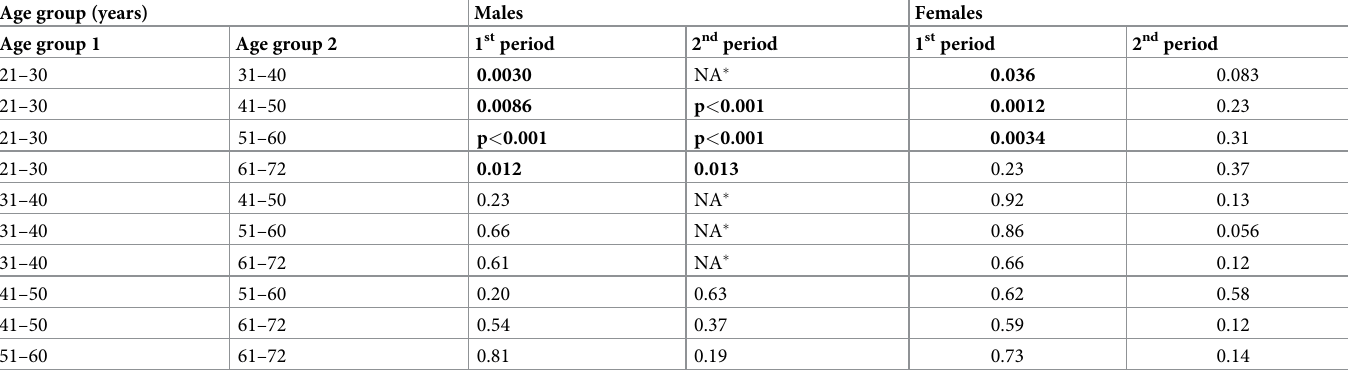
Probabilities by t-tests and bootstrapping are provided, with significant associations shown in bold. �